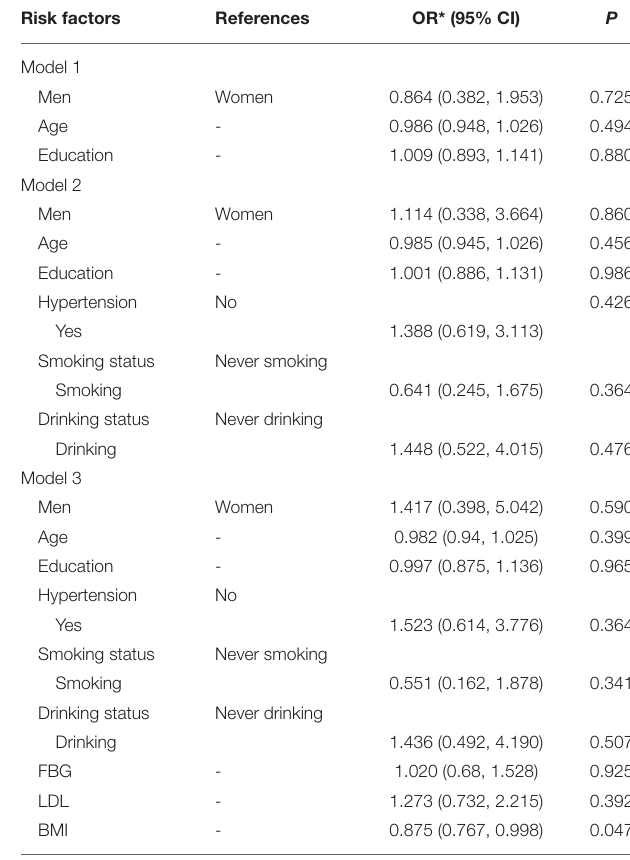
TABLE 2 | Associated factors of intracranial aneurysm in the univariate analysis among people with family history of stroke.